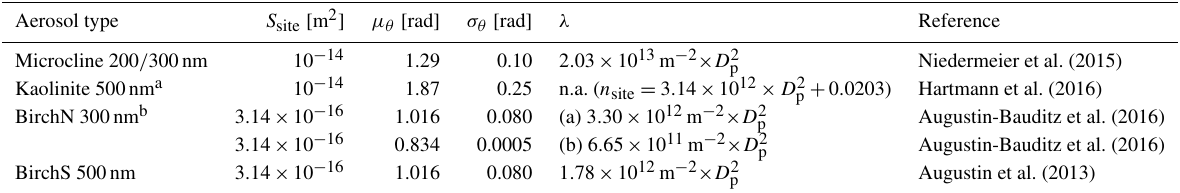
Table A1. Parameters used for SBM calculations shown in Fig. 2 with the fractions of multiple-charged particles (Table 1). The average contact angle, µ θ , and the standard deviation, σ θ , of the contact angle distribution and λ as a function of the particle diameter ( D p ) and S site are taken from